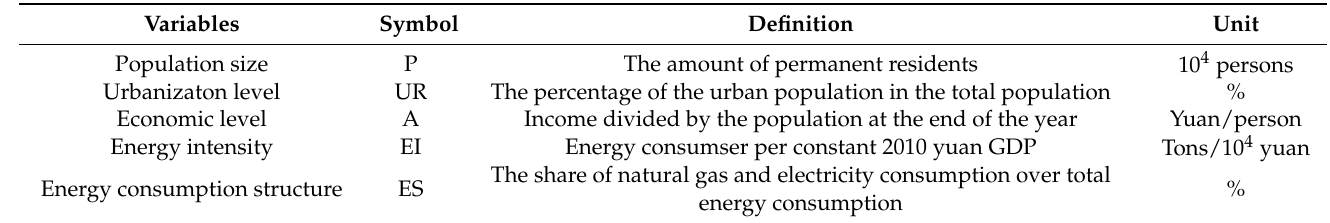
Table 1. Description of variables used in the analysis for the periods 2010–2019.